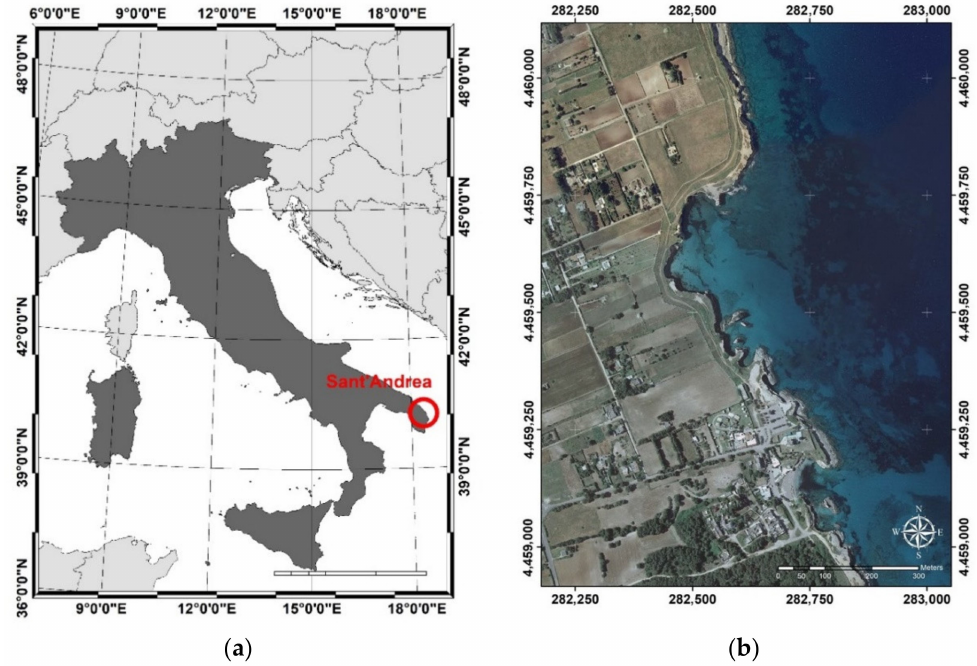
Figure 2. Study area: ( a ) identification of the area of interest and ( b )